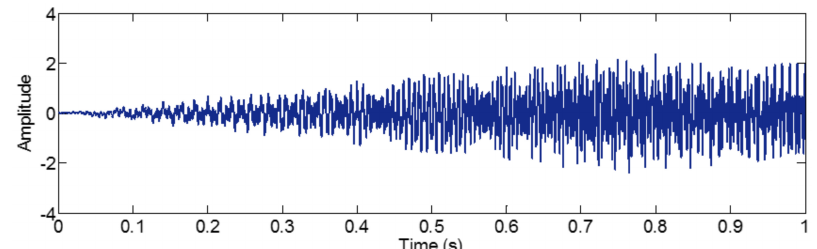
Figure 39. The waveform of the sample signal f sig 8 .